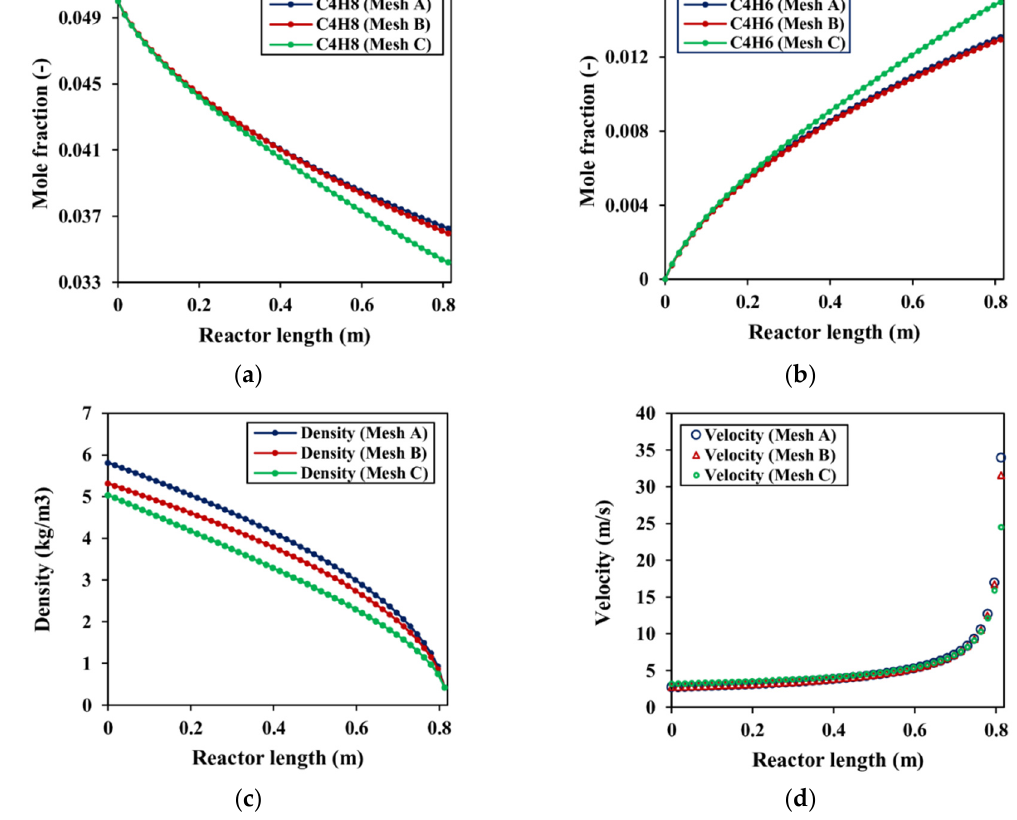
Figure 4. Mesh independency test results: ( a ) mole fraction of butene; ( b ) mole fraction of butadiene; ( c ) gas density; ( d ) gas velocity.